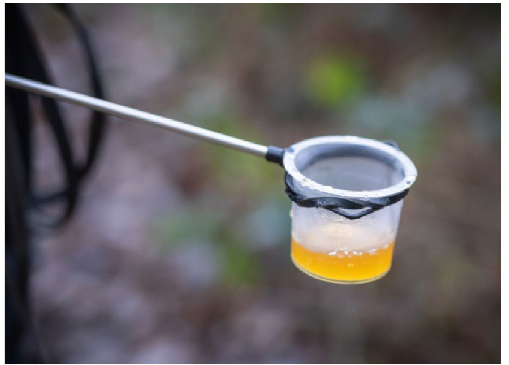
Figure 1. Urine collection device used for dogs and wolves consisting of an expandable metal stick and a plastic